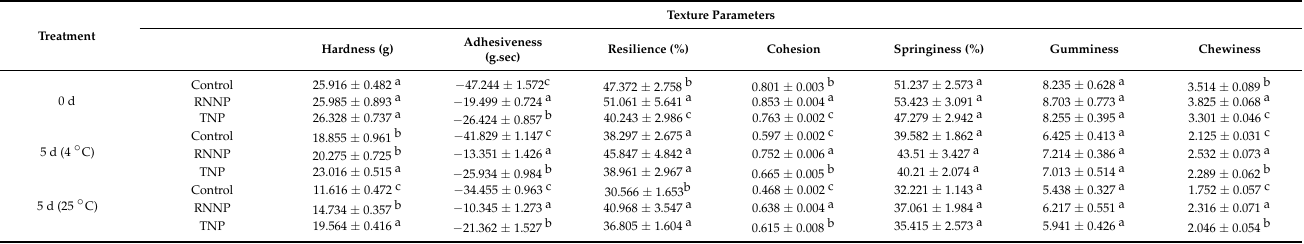
Values are expressed as mean ± SD. a–c Different superscript within the same column represent significant differences ( p <